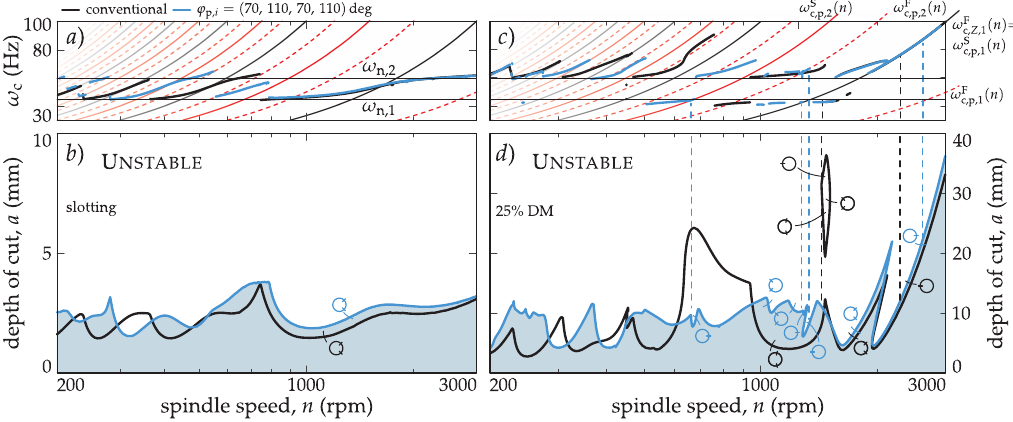
Figure 2. Comparison of milling stability for a four insert ( Z = 4) regular pitch tool versus a variable pitch tool, ϕ p, i = (70, 110, 70, 110) deg in case of slotting ( a,b ) and 25% down milling (DM, c,d